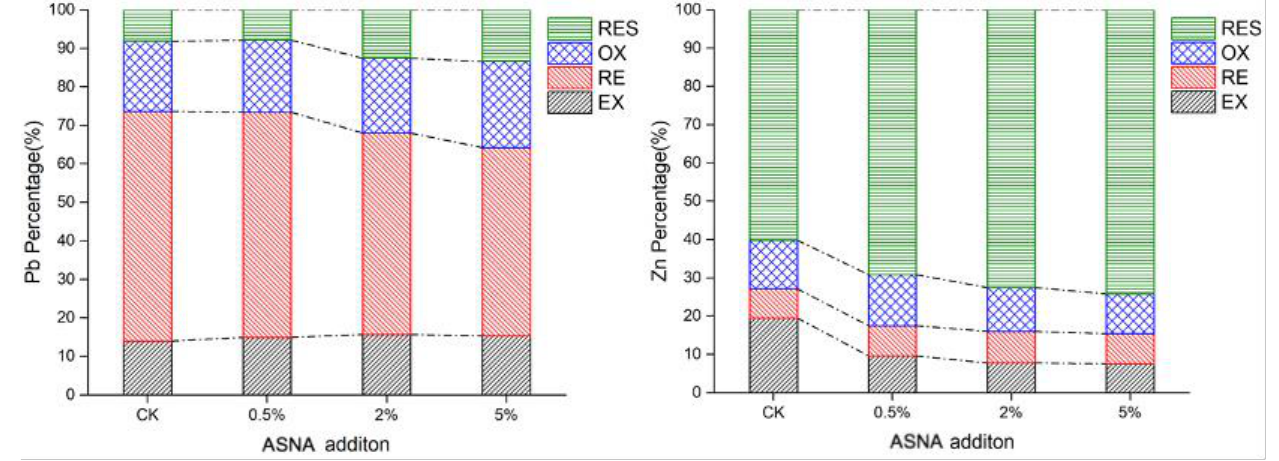
Figure 5. The chemical speciation of Pb and Zn in soils with different addition amounts of ASNA. Unlike lead, in the absence of the ASNA, zinc is mainly present in the RES, accounting for 60.2%. After adding the ASNA, the RES of zinc is further improved. When the addition